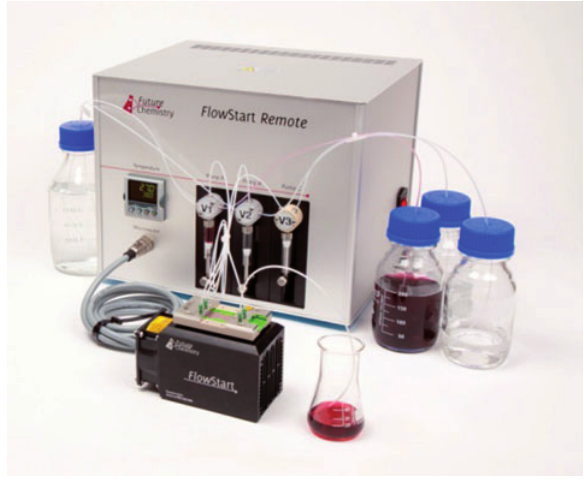
Figure 2 Flow Start